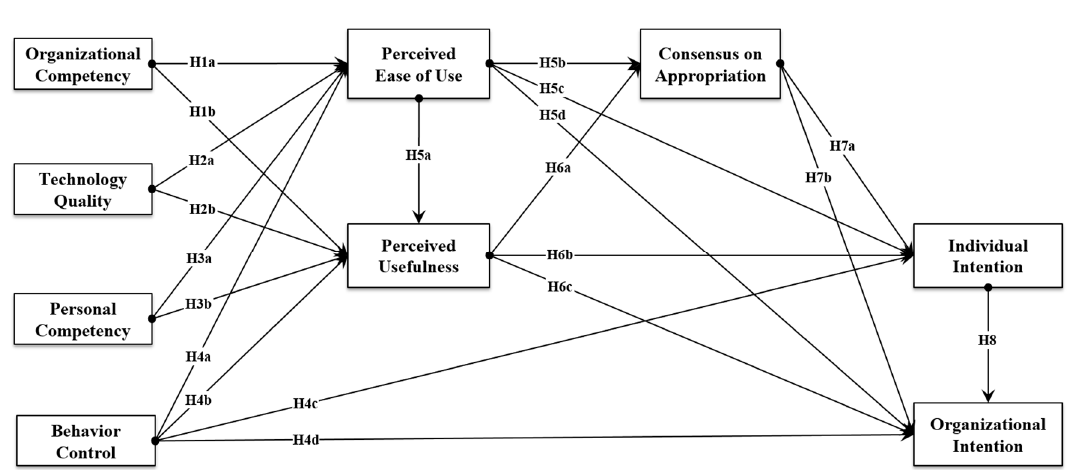
Figure 1. Research Figure 1. Research model.